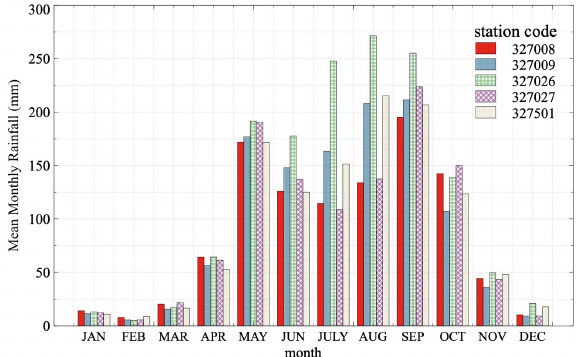
Fig. 2. Study area and location of rainfall stations used in the study.